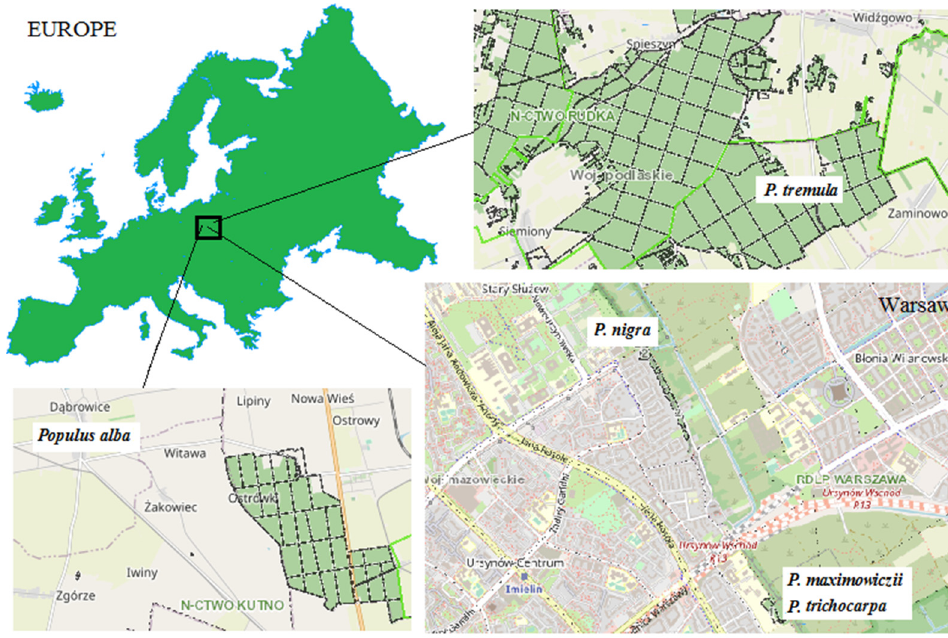
Figure 1. Origin (place of harvest) of poplar trees (https://www.bdl.lasy.gov.pl/, accessed on 1 IV